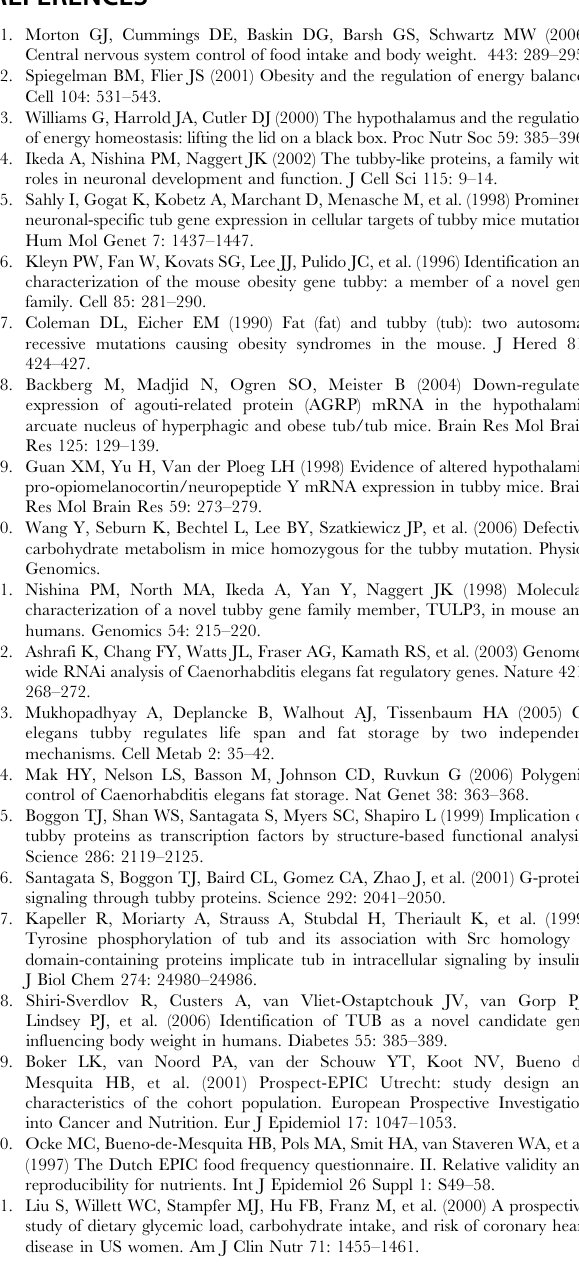
Figure S1 Detailed picture of TUB gene and it’s 3 9 flanking region and the location of all SNPs currently to be found in HapMap in this region (http://www.hapmap.org). The pairwise linkage disequilibrium (LD) plot, calculated as r2, among SNPs is shown, with red colour indicating increasing level of LD as measured by D’. The red boxes indicate SNPs genotyped in this